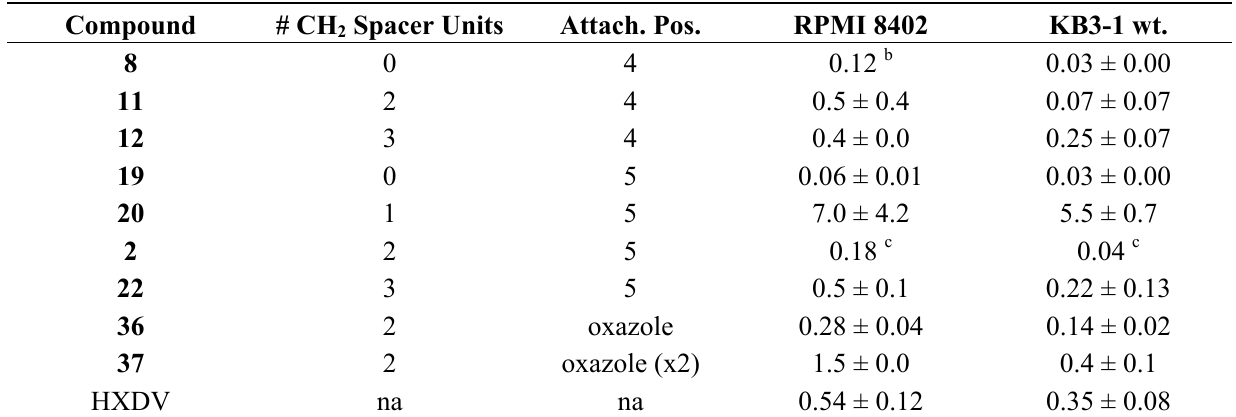
values ( μ M) a 50